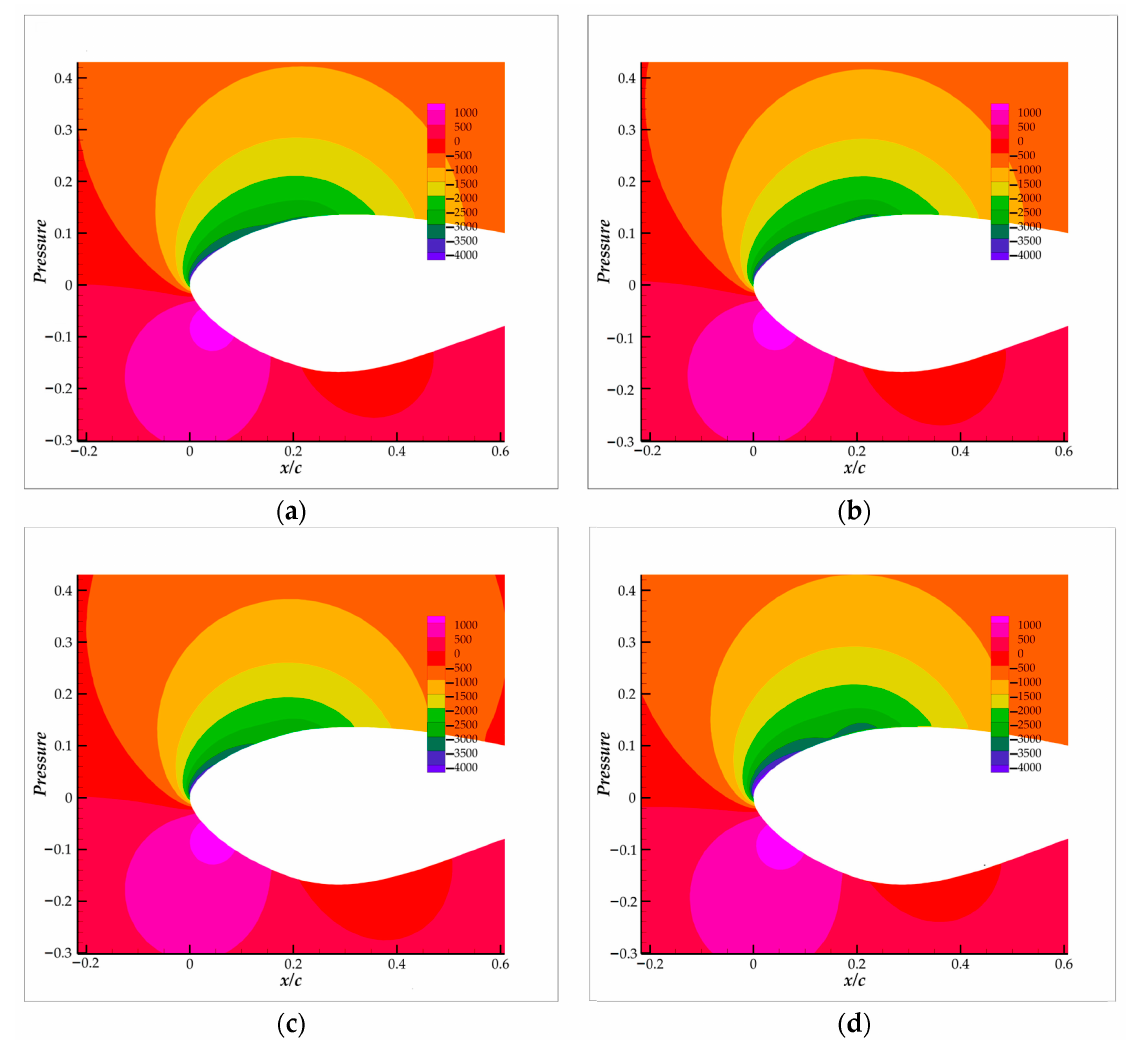
Energies 2023 , 16 , x FOR PEER REVIEW 19 of 24 Figure 20. Static pressure field: ( a ) 0.5–2, α = 12 ◦ ; ( b ) 0.5–6, α = 12 ◦ ; ( c ) 0.8–2, α = 14 ◦ ; ( d ) 0.8–6, α = 14 ◦ .